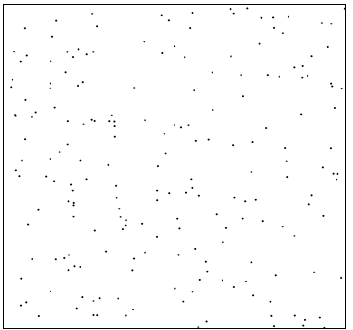
Figure 7. Random topology with 200 sensor nodes in 2,000 × 2,000 m 2